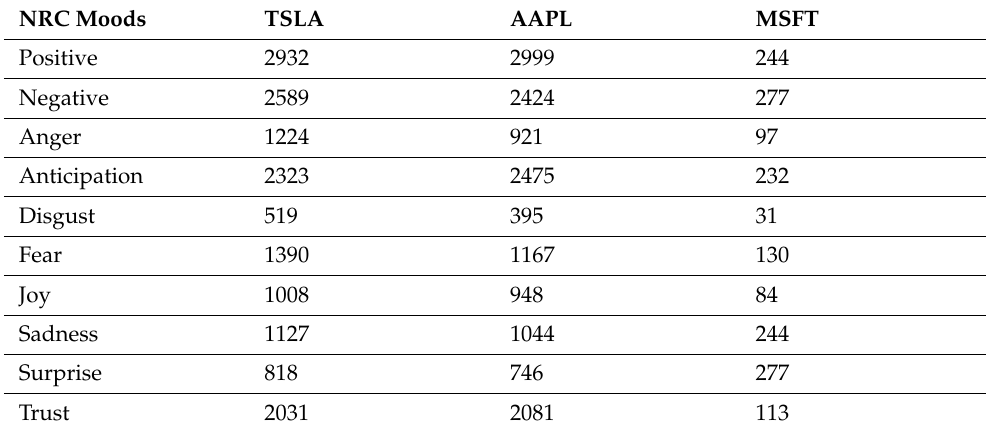
Table 5. Initial Data Exploration of NRC Lexicon.